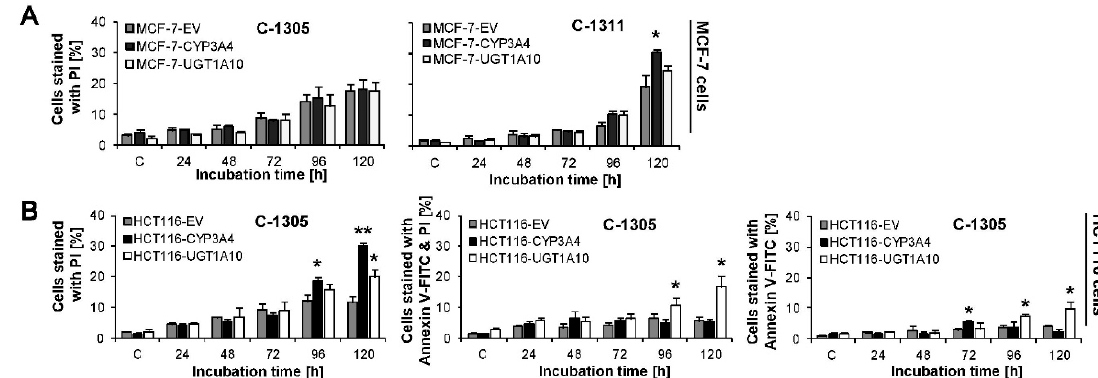
Figure 9. Quantitative analysis of phosphatidylserine externalization and membrane disruption in MCF-7 and HCT116 cells after 120 h of treatment with C-1305 and C-1311 at IC 90 . ( A ) Three types of PI-positive stained MCF-7 cells after 120 h of C-1305 and C-1311 treatment; ( B ) Populations of cells from individual quadrants: annexin V positive or annexin V and PI positive or PI positive, obtained from annexin V/PI test conducted for three types of MCF-7 and HCT116 cells exposed to C-1305 and C-1311 at IC 90 . Significant differences in cell percentages between control, stably transfected with EV cells and UGT1A10- or CYP3A4-transfected are indicated as follows: * p ≤ 0.05; ** p ≤ 0.001.